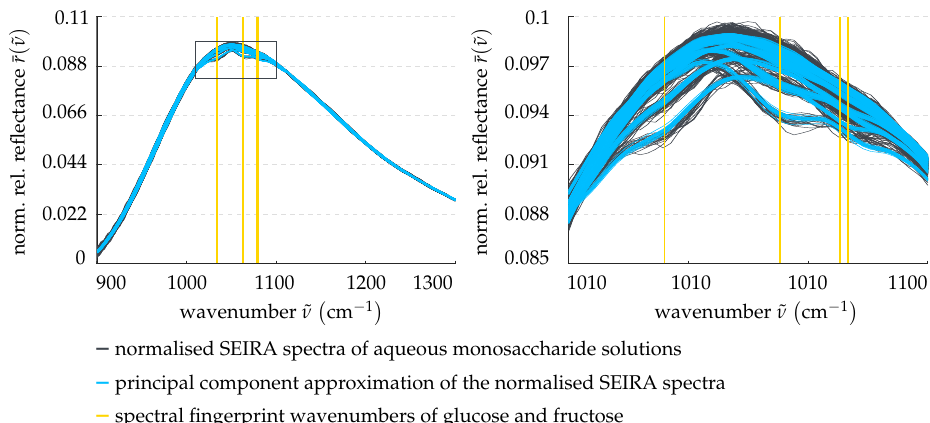
Figure 6. Pre-processing step 2: approximation of the SEIRA spectra by the four main principal components identified in the training data. ( Left panel ) normalised SEIRA spectra and their principal component approximation. ( Right panel ) magnification of the boxed area in the left